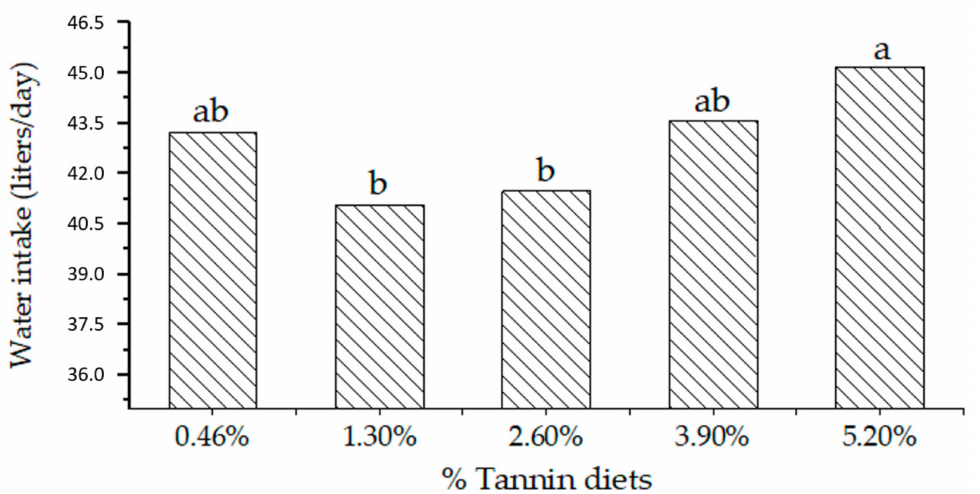
Figure 3. Daily water intake of lactating dairy cows fed dietary diets containing various tannin levels. Different lowercase letters (a, b) indicate differences among tannin diets (axis: X) according to the Tukey test at the 5% probability